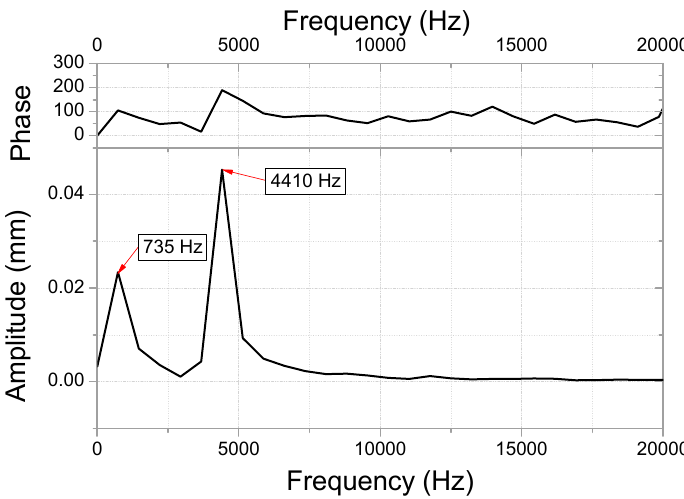
Figure 10. Y-displacement of the spring with and without damping in the second-step analysis.